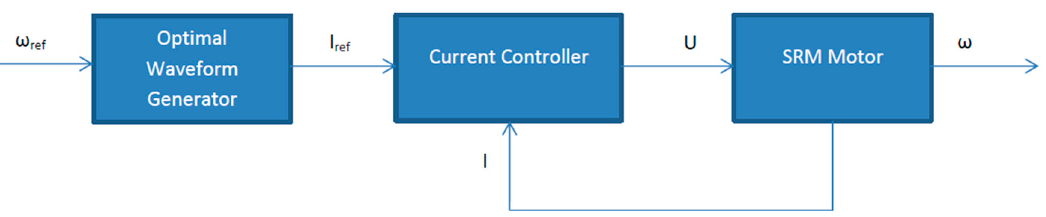
Figure 13. Flowchart of the closed loop control system.